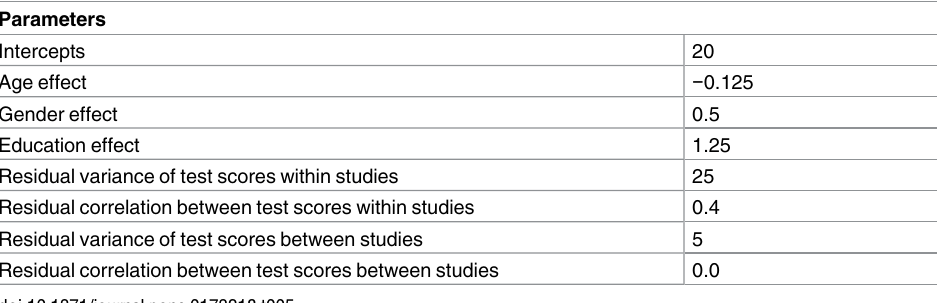
Fig 2. Missing data patterns for the 0%, 40% and 70% missing data conditions, with studies on the y-axis and tests on the x-axis. Colored boxes are non-missing test scores, white boxes are missing test scores. doi:10.1371/journal.pone.0173218.g002 Table 5. Parameter values in the two simulation